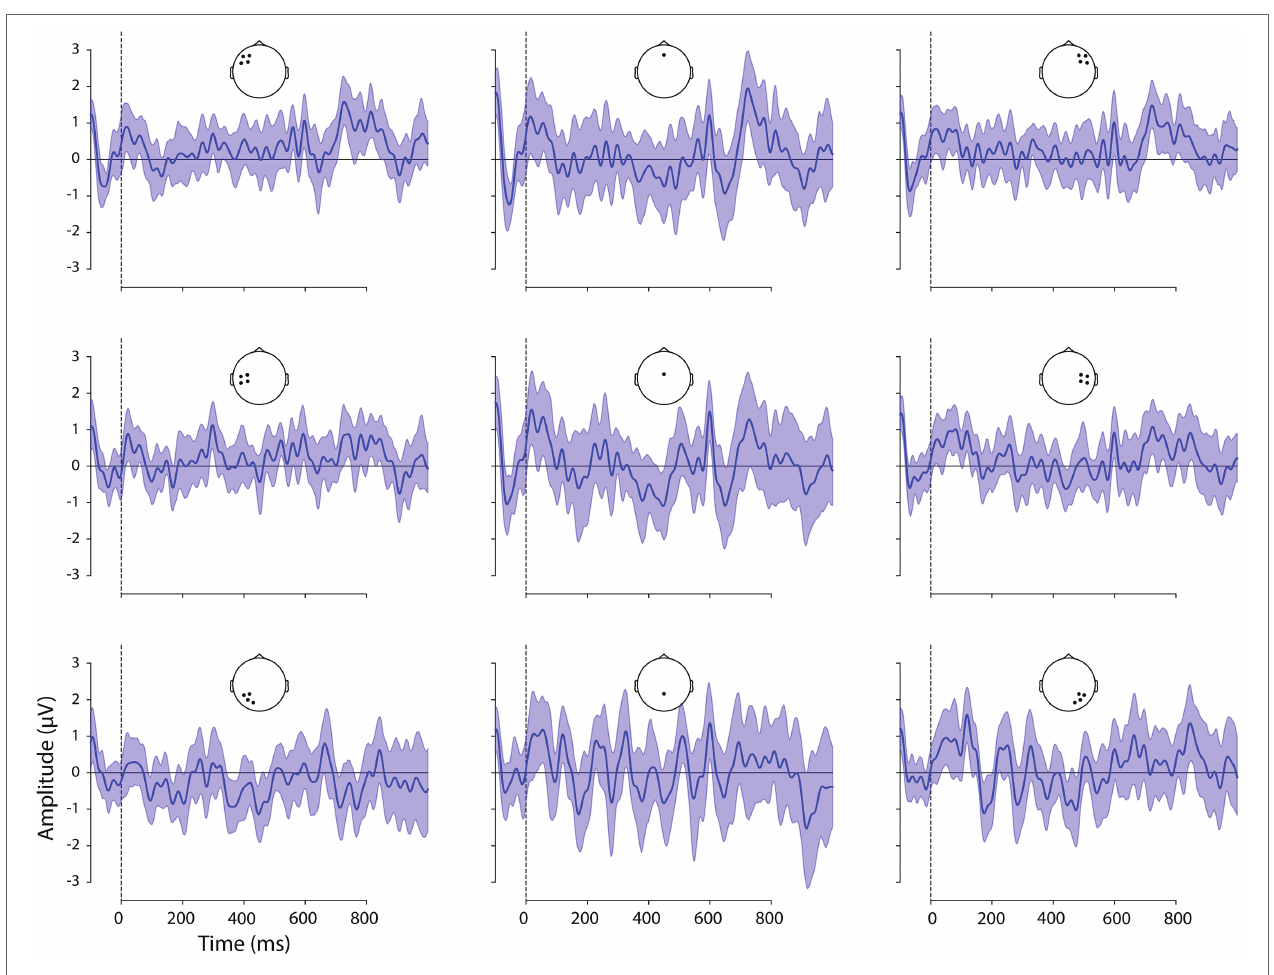
FIGURE 5 | Difference waveforms, the ERPs to V2 word order subtracted from that to V3 word order following kanske ‘maybe’ at the nine ROIs. Confidence intervals are shaded. Positive plotted